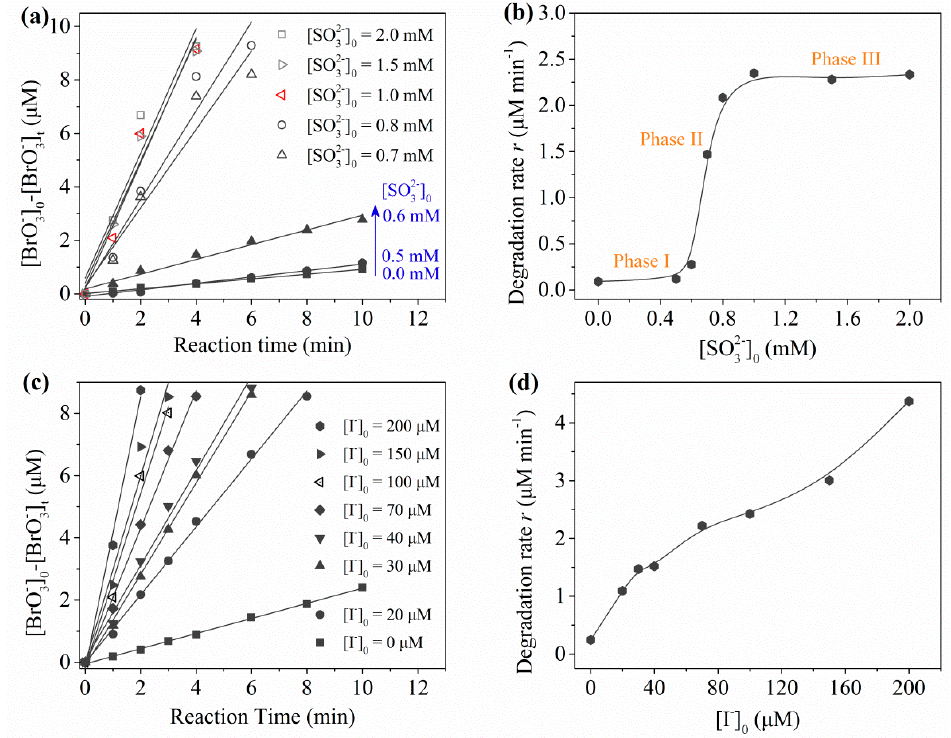
Figure 4. Degradation of BrO − using UV/sulfite/I − process: ( a ) effects of sulfite dosage ([I − ] 0 = 100 µ M); ( b ) degradation rate constant ( r ) vs. [sulfite] 0 ; ( c ) effects of I − dosage; ( d ) degradation rate constant ( r ) vs. [I − ] 0 . Conditions: [BrO − ] 0 = 10 µ M, pH = 9.2, [DO] 0 = 7.0 mg · L − 1 , 20 ± 1 ◦ C.